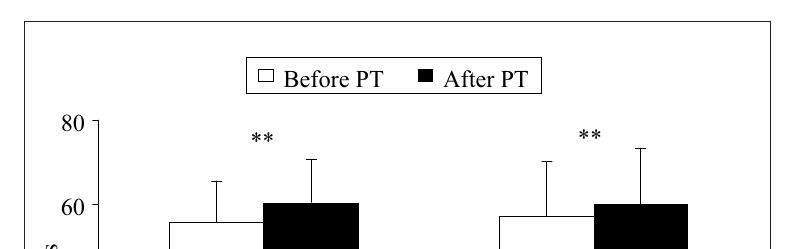
Figure 4. Changes in balance evaluation values in the control and the test groups